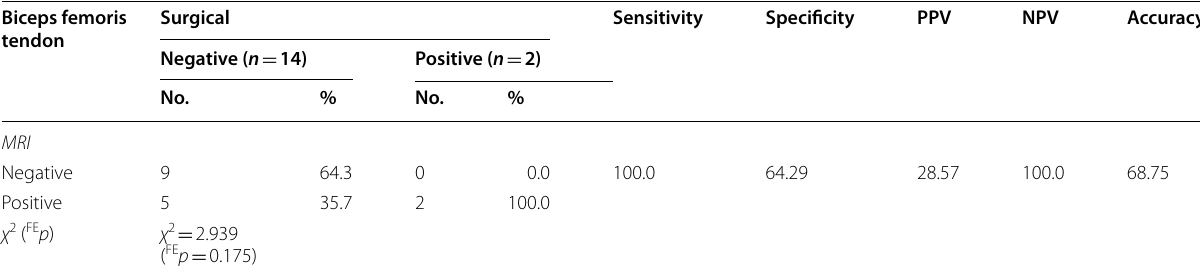
Table 7 Agreement (sensitivity, specificity, and accuracy) for biceps femoris tendon ( n